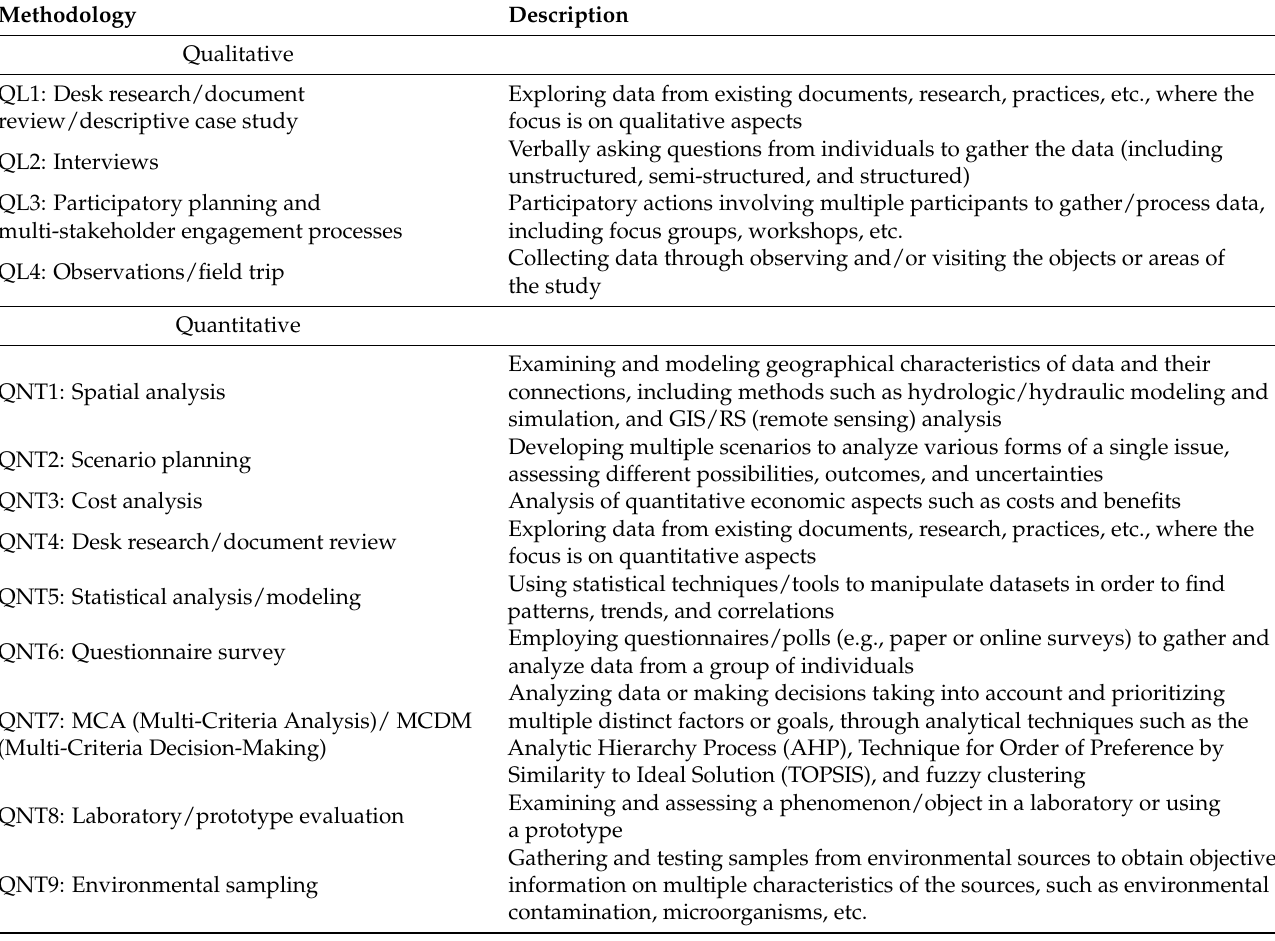
Table 4. Brief descriptions of the methodologies used in the reviewed